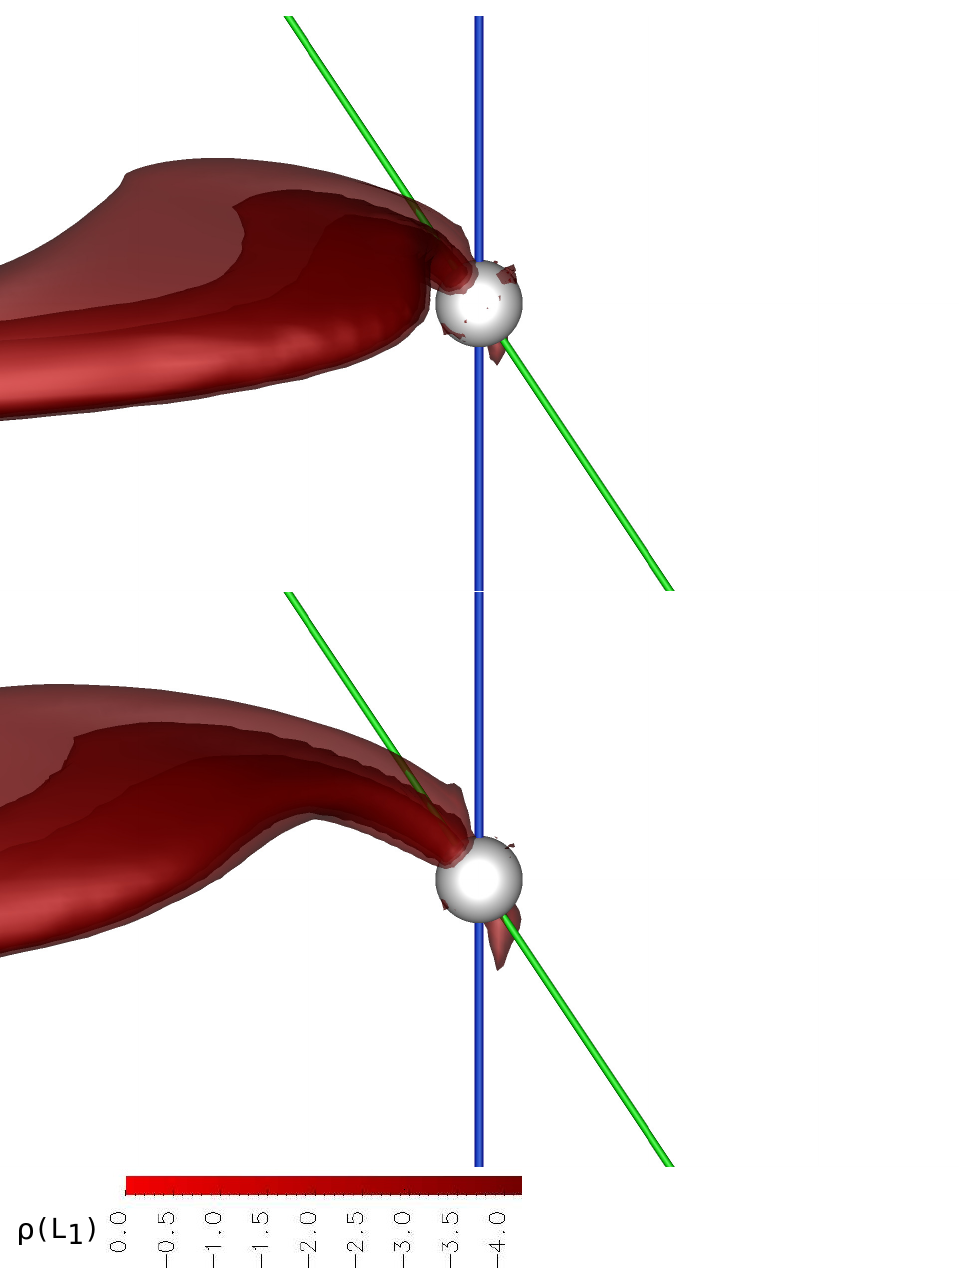
system are presented in Figures 2 and 3. The figures show the iso-surfaces of the density logarithm in units of the density value at the Lagrange point L 1 . It should be taken into account that when constructing each panel, an individual density scale is used relative to a given value ρ ( L 1 ) since ρ ( L 1 ) depends on the mass transfer rate.